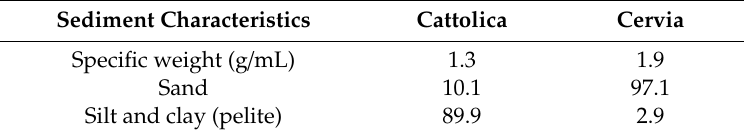
Table 1. Characteristics of the sediment in each plant installation. Specific weight is measured accordingly to [19].